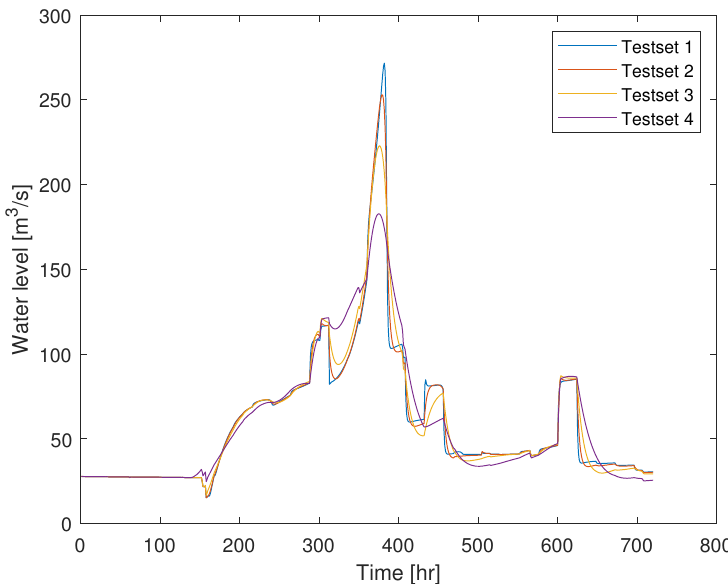
Figure 7. Flowrate of water at downstream, V O , with different sets of parameters when the length of prediction horizon, N p , is set as 3